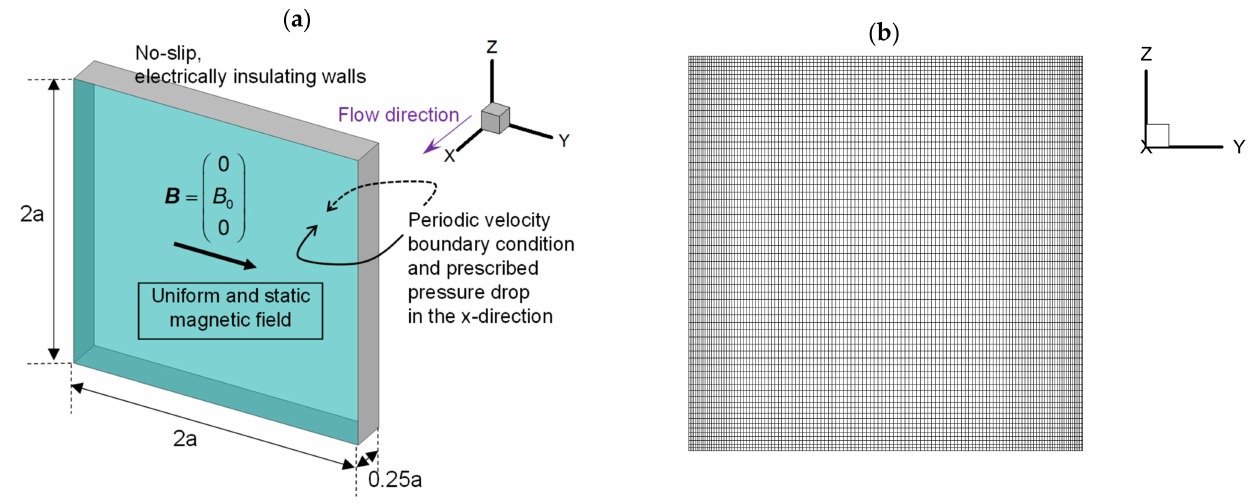
Figure 1. Computational domain and boundary conditions for single-phase liquid-metal flow in a square channel ( a ), and the computational grid for Grid index = 2.00 in the Y–Z plane ( b